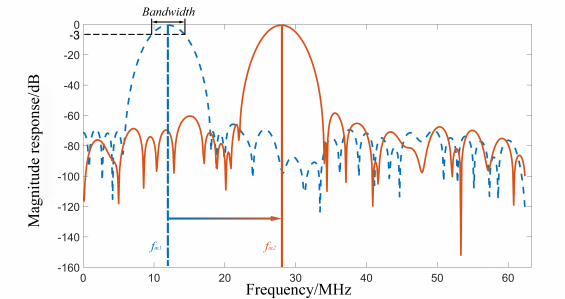
Figure 4. Diagram of the filter passband change.